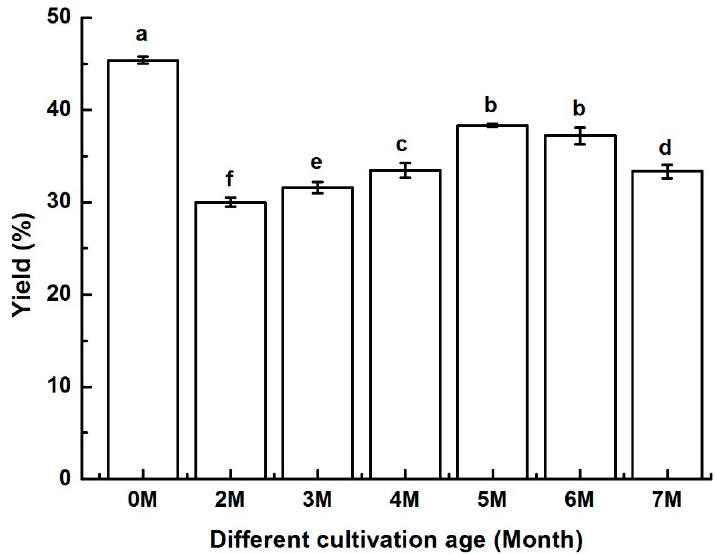
Figure 3. Kinsenoside yield in A. roxburghii at different cultivation ages. Note: Different letters in the figures indicate significant difference at 0.05 level.